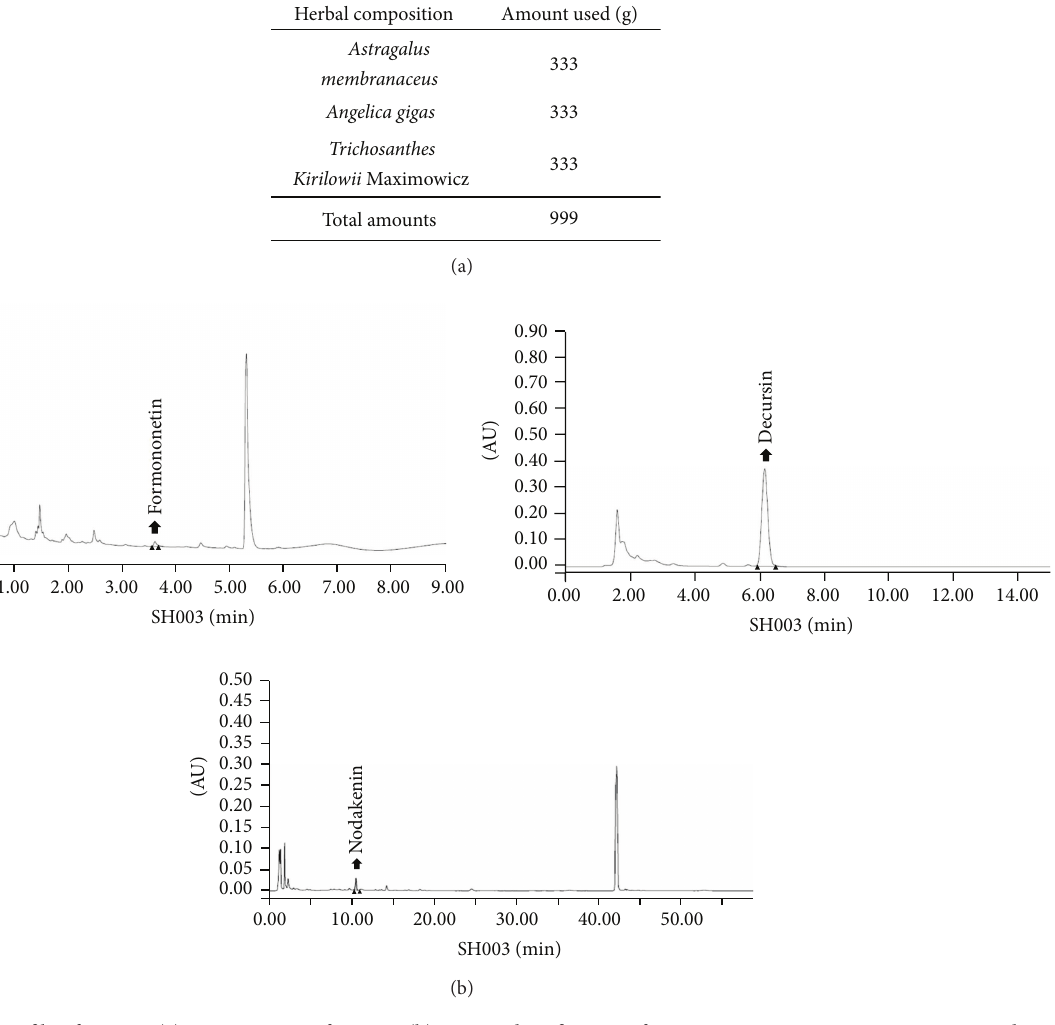
󸀠 5 -GTTGTGTCTTGCCATGCTAAAG-3 AGCCTCAGACATCTCC-3 󸀠 . ELISAs were performed with human IL-6 ELISA kit (BD Biosciences,San Jose CA,